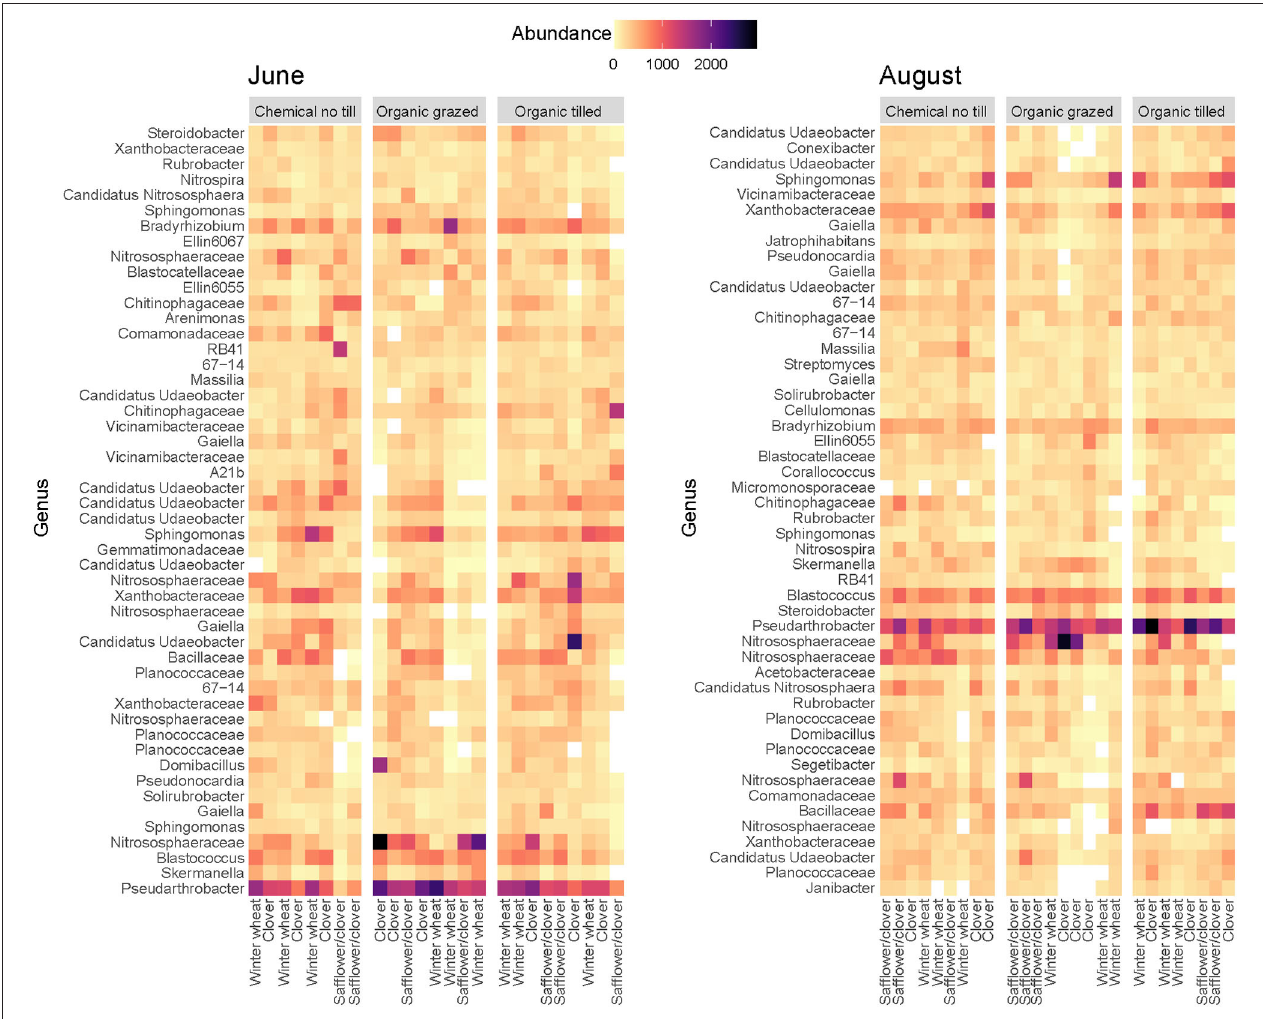
FIGURE 2 | Abundance of the most abundant sequence variants identified at the genus level in three contrasting dryland cropping systems. Sequence variants from unspecified genera are identified at the family